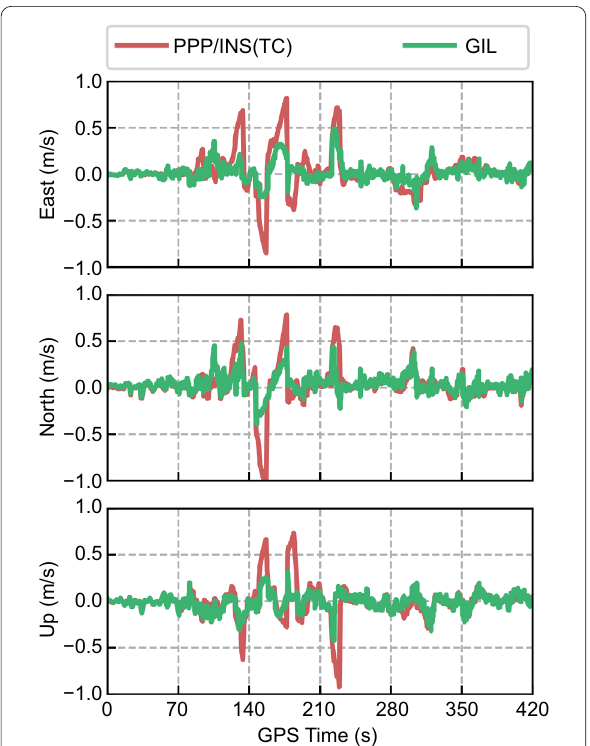
Fig. 15 Velocity offsets of multi-GNSS PPP/INS and GIL methods in GNSS difficult experiment